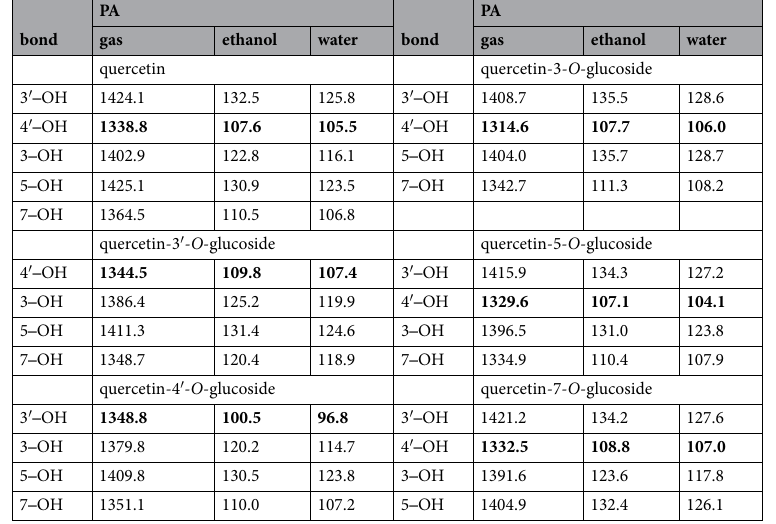
Table 5. Proton affinities (PA) in kJ/mol obtained at M062X/6–311 + G ** level of theory.